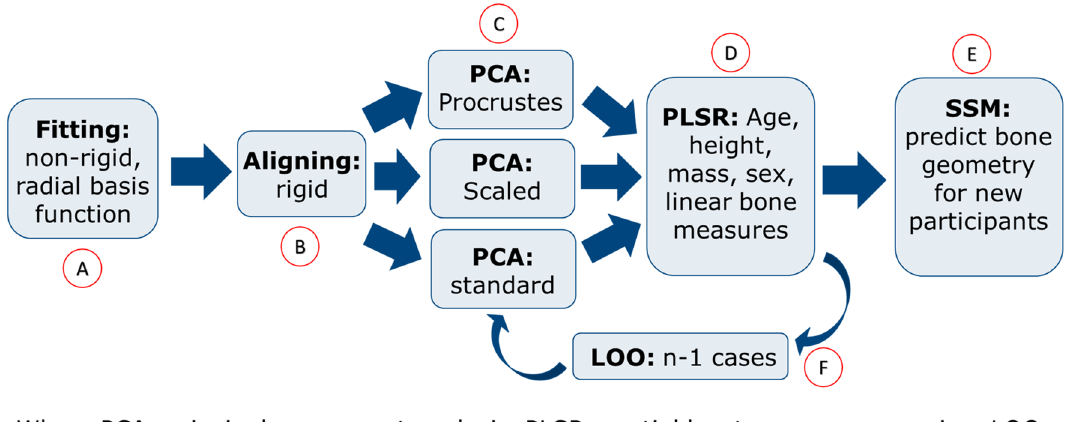
Figure 1. Workflow for the development of PCA (A, B and C) and modelling and testing of the statistical shape model (D, E and